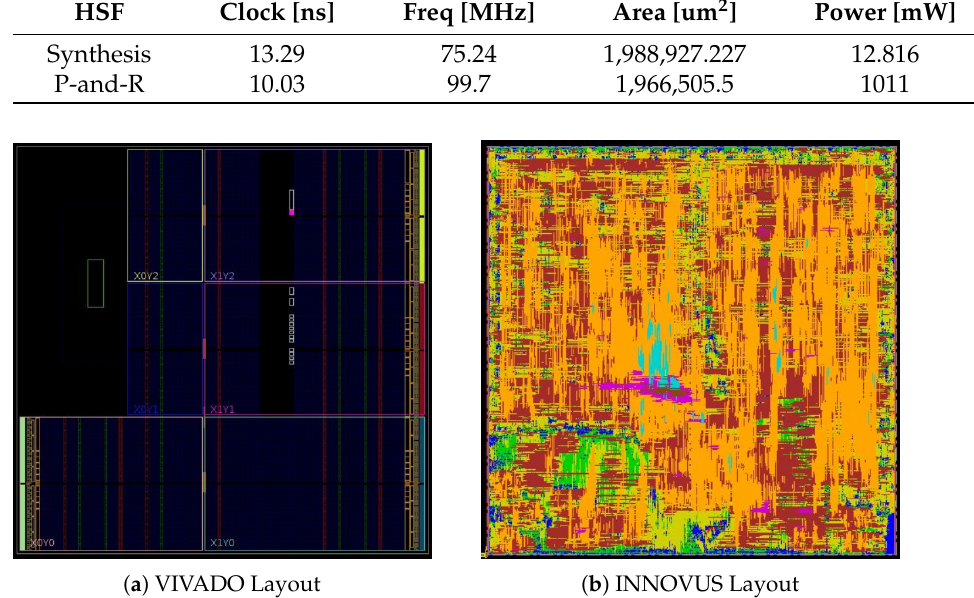
Figure 8. Layouts of the Wiener